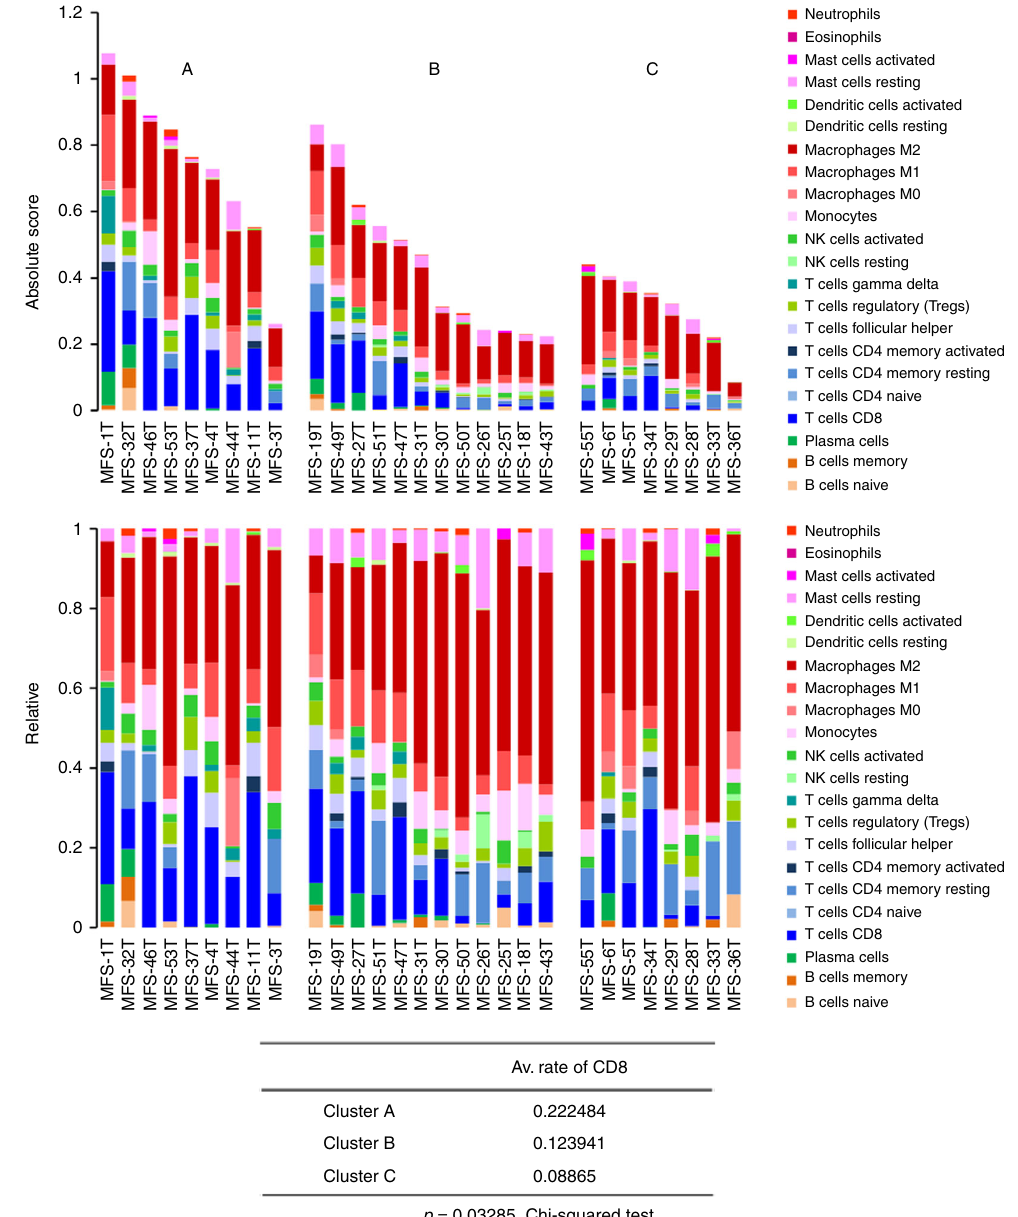
Fig. 5 Evaluation of immune cell fraction in MFS. Signi fi cant difference of immune cell composition was observed among three clusters with distinct methylation pro fi les. The average fraction of CD8 + T cell was signi fi cantly higher in Cluster A with better prognosis compared to others ( p = 0.033, χ 2